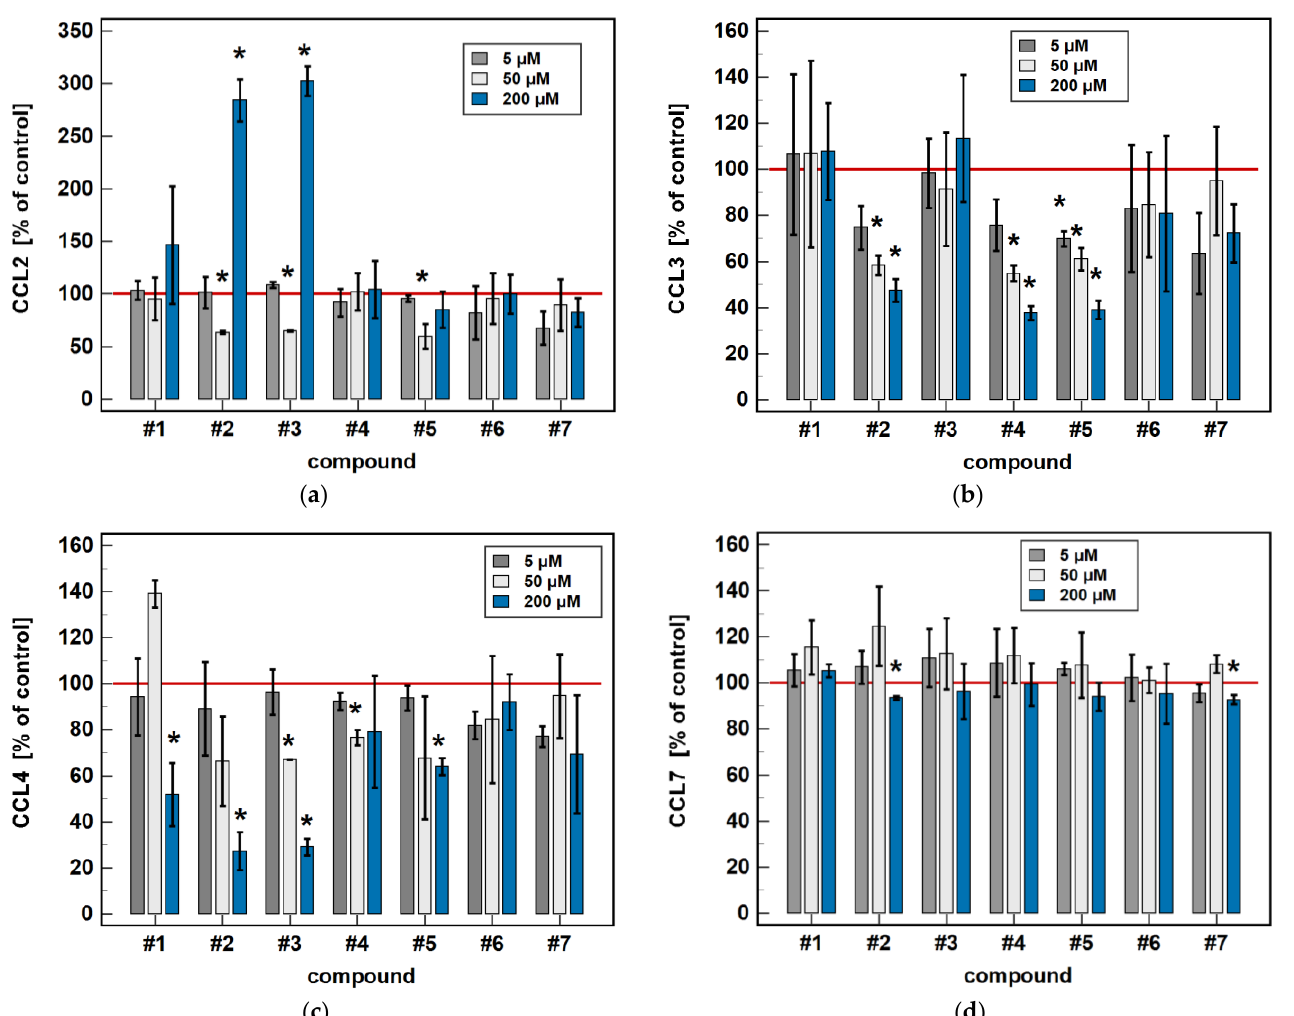
( d ) Figure 7. Time-dependent effect of oxicams on MCPs and MIPs secretion in Caco-2 cells: ( a ) MCP-1/CCL2; ( b ) MIP- 1α/CCL3; ( c ) MIP- 1β/CCL4; ( d ) MCP-3/CCL7. The bars represent the mean ± SD (whiskers) ratio of the chemokine con- centration in the medium from cells treated with 200 μM oxicams for 6 and 24 h, as compared to untreated controls, expressed as a percentage. The significant differences between the secretion from treated and untreated cells, analyzed using a t -test for one mean, are indicated by asterisks (*). The reference secretion of the control cells is indicated by a red solid line. Compound # 6 denotes piroxicam, and # 7 denotes meloxicam. The oxicam effect on the secretion of MCP-1/CCL2 mimicked that of CCL2 expres-